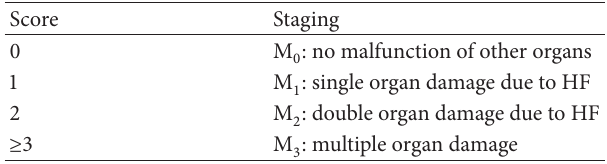
Table 4: Staging of malfunction of other organs.